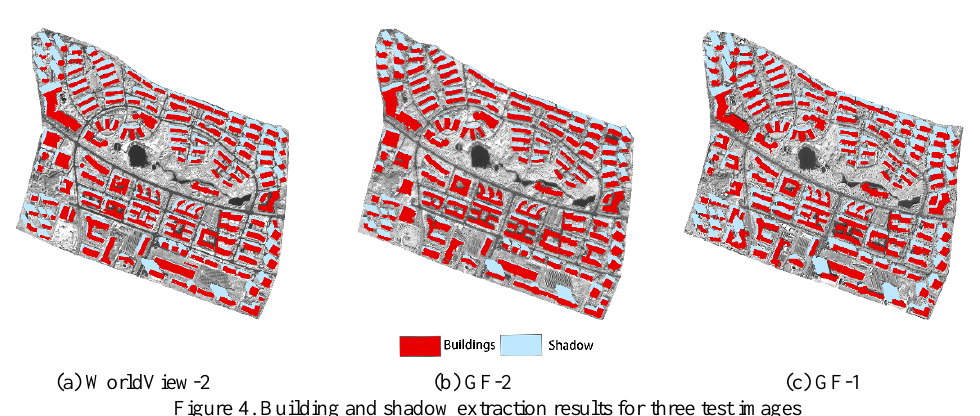
Figure 4. Building and shadow extraction results for three test images